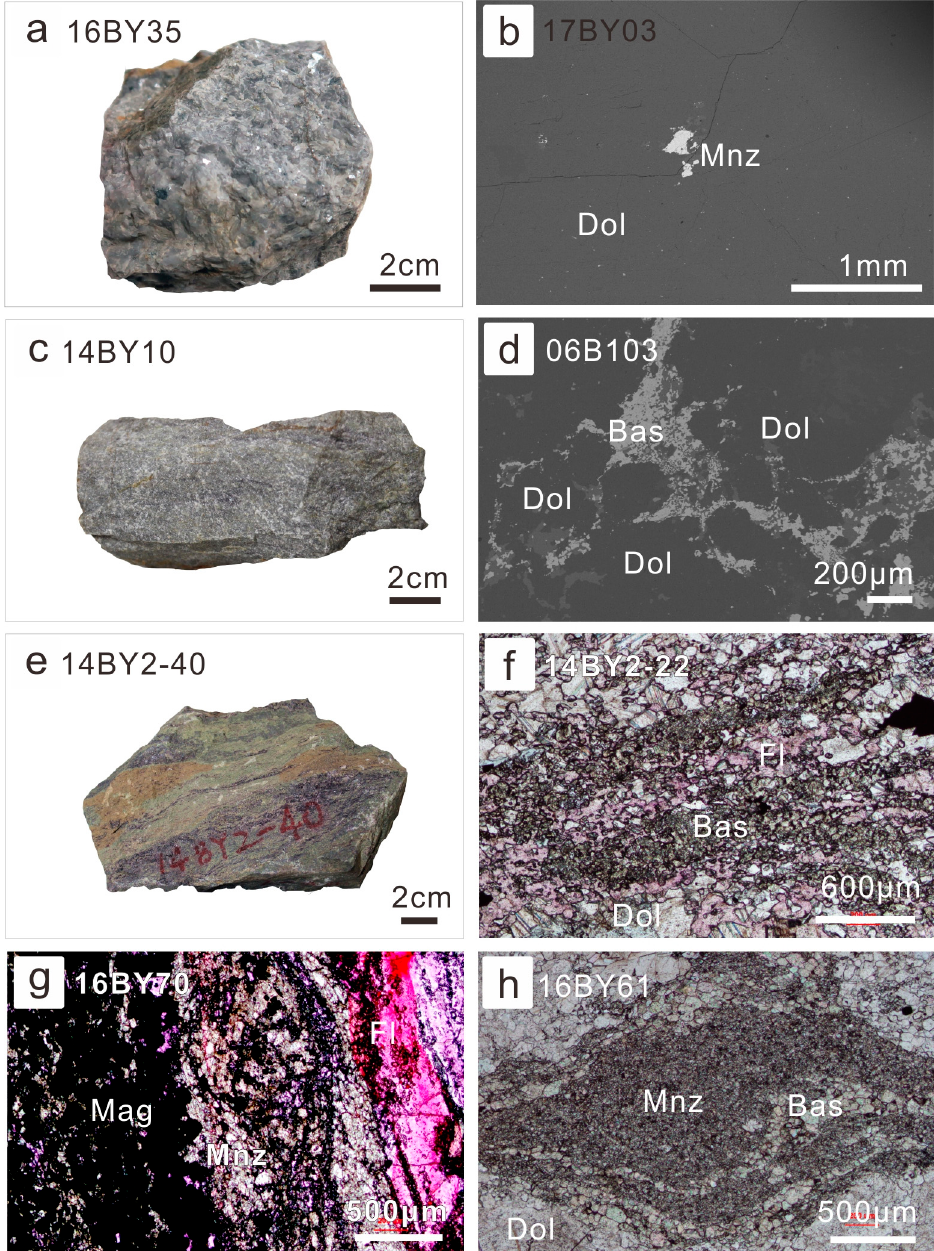
Figure 2. Petrography of ore-hosting dolomite with diverse degrees of alteration: ( a ) photography of the coarse-grained ore-hosting dolomite (sample No. 16BY35); ( b ) discrete monazite grain in the coarse-grained ore-hosting dolomite (backscatter electron (BSE) image of sample 17BY03); ( c ) photography of the slightly-altered fine-grained ore-hosting dolomite (sample No. 14BY10); ( d ) interstitial bastnaesite aggregates among relatively fine-dolomite grains (BSE of 06B103); ( e ) photography of the extensively-altered fine-grained ore-hosting dolomite (sample No. 16BY35); this sample was also called fluorite-aegirine-rich ore; ( f ) bastnaesite in the fluorite-rich ores under plane polarized light (14BY2-22); ( g ) monazite associated with fluorite and iron oxide in the aegirine-rich ores under plane polarized light (16BY70); ( h ) the association of monazite (fine-grained) and bastnaesite (coarser-grained) in the fine-grained ore-hosting dolomite (16BY61). Abbreviation of minerals: Dol—dolomite; Mnz—monazite; Bas—bastnaesite; Fl—fluorite; Mag—magnetite.